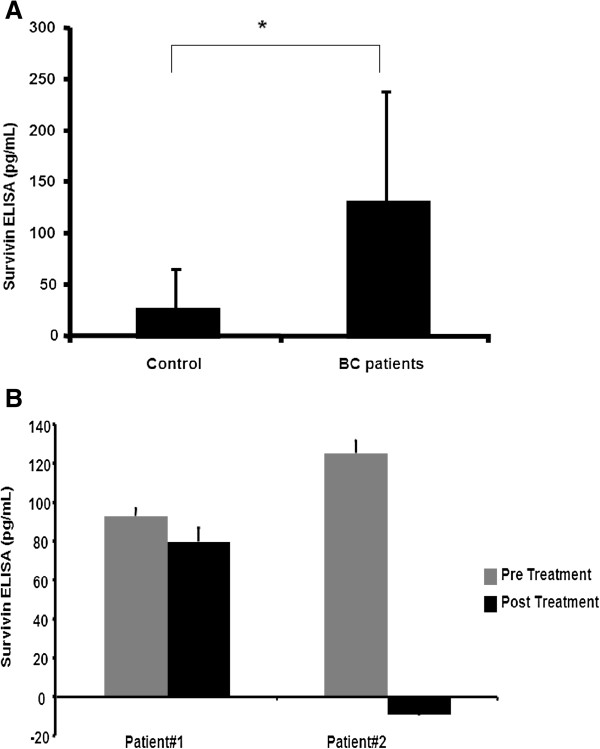
Survivin quantification in patient sera. (A) Survivin ELISA in control (with no recurrence after initial treatment) and breast cancer patients’ sera. Survivin level was compared with active breast cancer cases (n = 40) to controls (n = 10). Survivin values less than 50 pg/mL were considered normal while a Survivin level of 50-70 pg/mL was considered mild, 70-90 pg/mL moderate and >90 pg/mL as high. (*p < 0.05) (B) Treatment may affect patient sera Survivin levels. In two patients (patient#1), (patient#2) serum Survivin level are measured before and one year after treatment. (Error bar = Mean+/-SD). (BC, breast cancer).